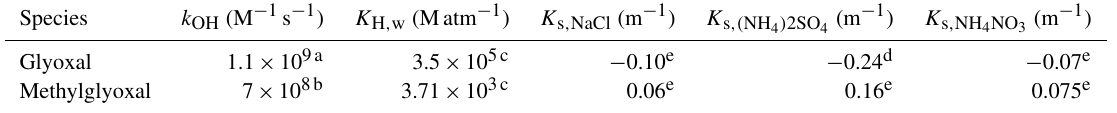
Table 2. Reaction and mass transfer